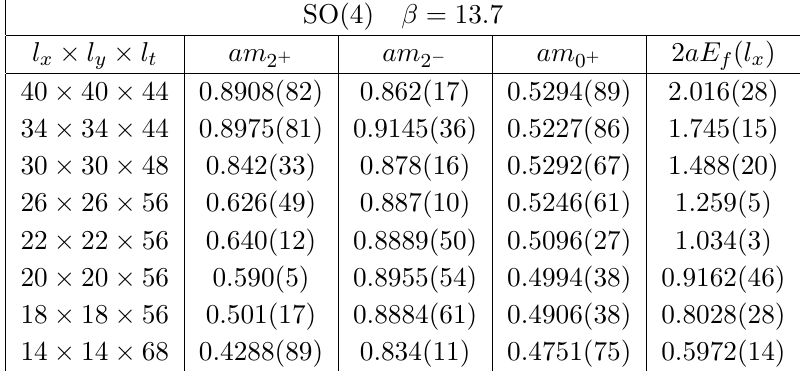
Table 7 . Lightest J P = 2 + ; 2 (cid:0) ; 0 + glueball masses on various l x (cid:2) l y spatial lattice volumes. Also twice the energy E f ( l x ) of the lightest fundamental (cid:13)ux tube that winds around the x -torus. In SO(4) at an inverse bare coupling (cid:12) = 8 =ag 2 = 13 :